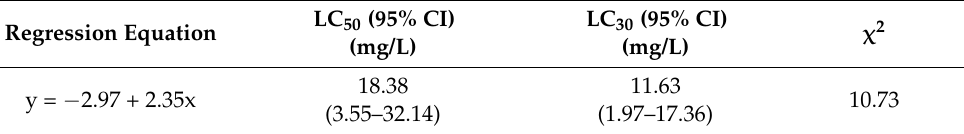
Table 1. Susceptibility of Plutella xylostella larvae to bifenazate. Regression